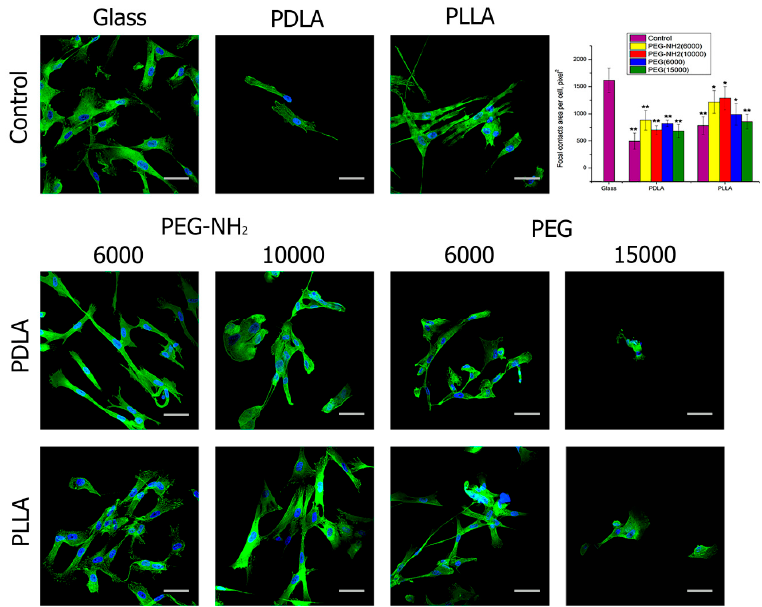
Figure 5. Presence of focal contacts of the MSC cells after one day of cultivation on the pure glass and on the pure films from PLA with different isomeric forms—PDLA and PLLA (control); the blend PLA/PEG or PLA/PEG-NH2 with different molecular weights of PEG (6000 or 15,000 g/mol) and PEG-NH2 (6000 or 10,000 g/mol). (N = 5: ⭑ — p < 0.01, ⭑⭑ — p < 0.05 for the same concentration data). Staining—vinculin (green), DAPI (blue). Scale bar 50 µm.